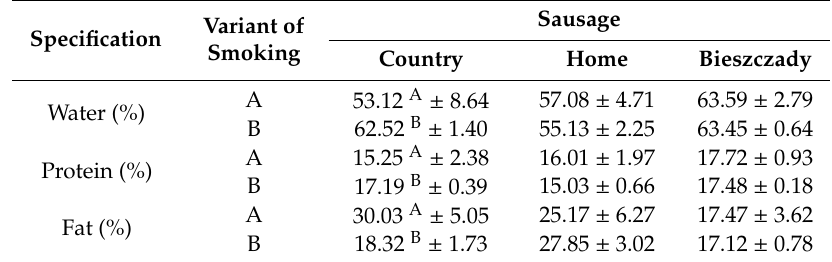
Table 2. Basic chemical composition of medium-ground sausages (2 samples × 10 batches × 2 variants × 3 types of sausages = 120 sausage samples) ( x ±